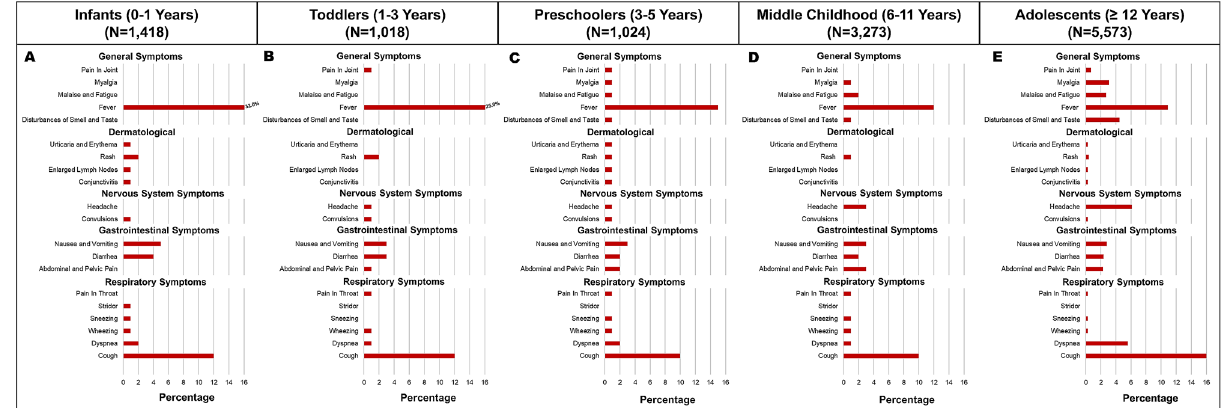
Figure 3. Frequency of symptoms in pediatric COVID-19 patients: stratified by